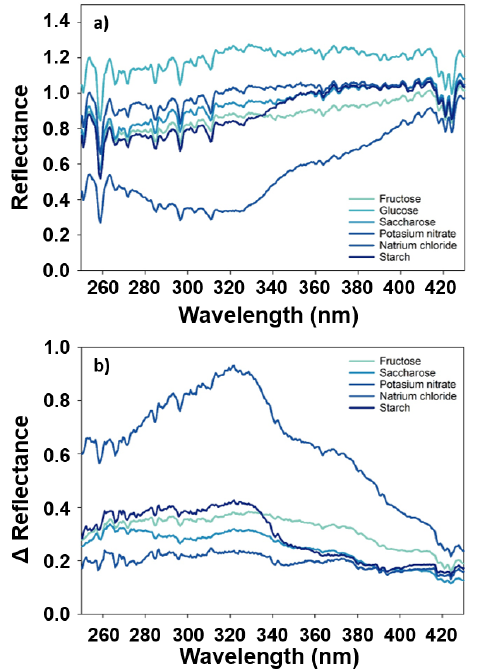
Figure A1. Spectral signatures of fructose, glucose, saccharose, potassium nitrate, sodium chloride and starch ( a ) and difference spectrum to glucose ( b ) measured with UV line